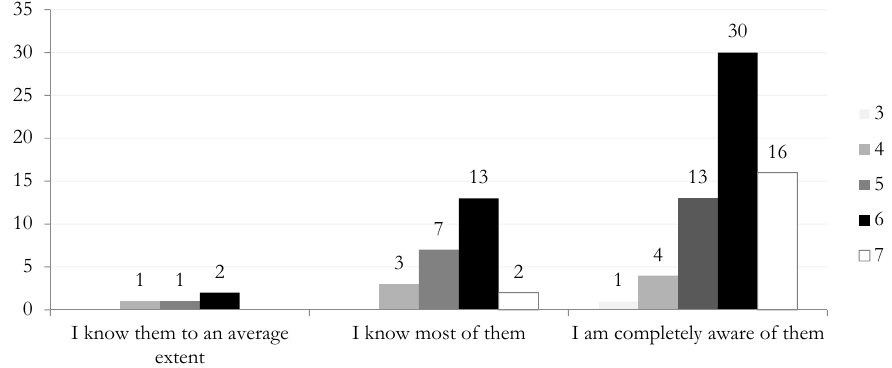
Fig. 1 - Correlation between knowing LEGO’s objectives and individual successfulness. Source: Author’s